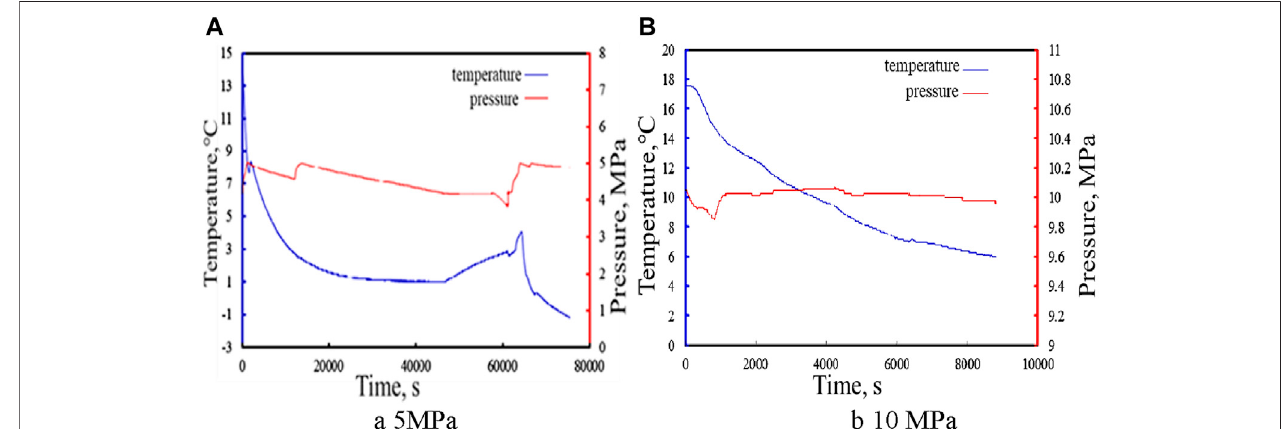
FIGURE 6 | Variation of temperature and pressure at 1% inhibitor concentration. ( A :5 MPa; B :10 MPa).